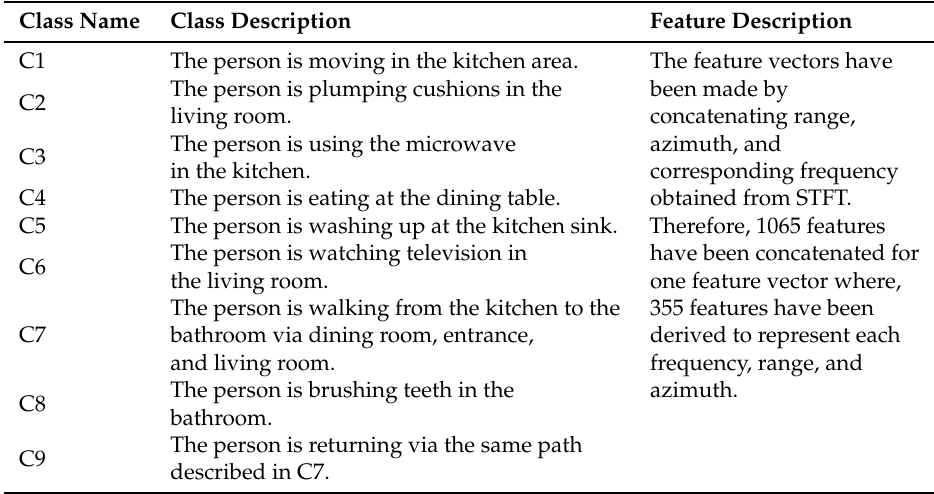
Figure 13. Distance and frequency mapping to agree the floor plan for different categorical events. Table 2. The categories, description, and the features used for event classification by support vector machine